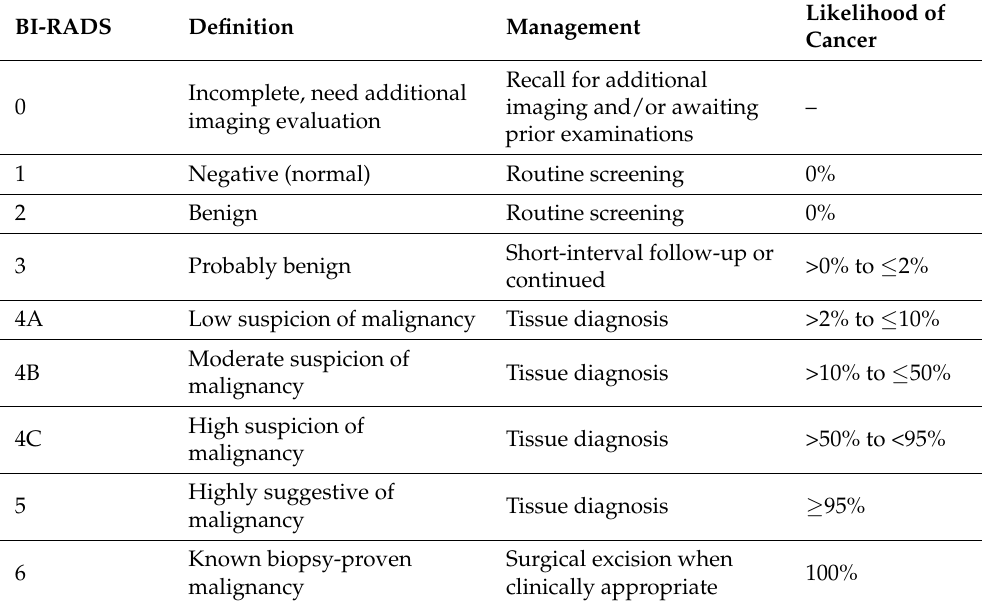
Table 1. Description and assessment of BI-RADS categories for mammograms.